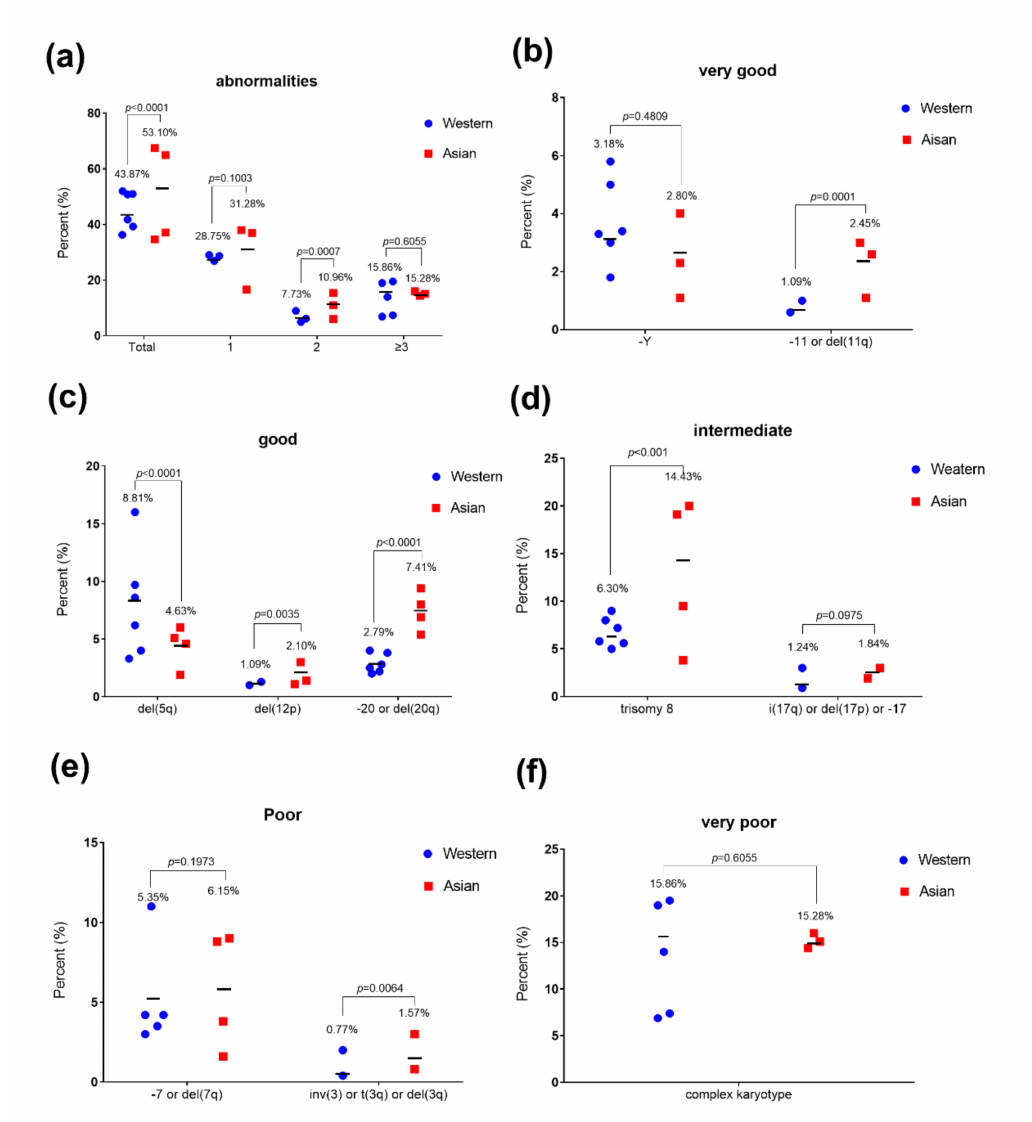
Figure 6. Karyotype distribution in Western and Asian MDS patients. ( a ) Percentage of total abnormalities, single abnormal- ity, double abnormalities, 3 and more than 3 abnormalities. ( b – f ) Karyotype distribution in each cytogenetic risk group depending on IPSS-R. Because of the different sources of the data, we did not list the results completely consistent with IPSS-R, -11/del(11q) instead del(11q) in very good group, -20/del(20q) instead del(20q) in good group, i(17q)/del(17p)/-17 instead i(17q) in intermediate group, -7/del(7q) instead -7 in poor group and ≥ 3 abnormalities instead >3 abnormali- ties in very poor group. Figure 6 has been drawn based on the data and publications [8,26,29,31,32,48–51] described in Supplemental Tables S4 and